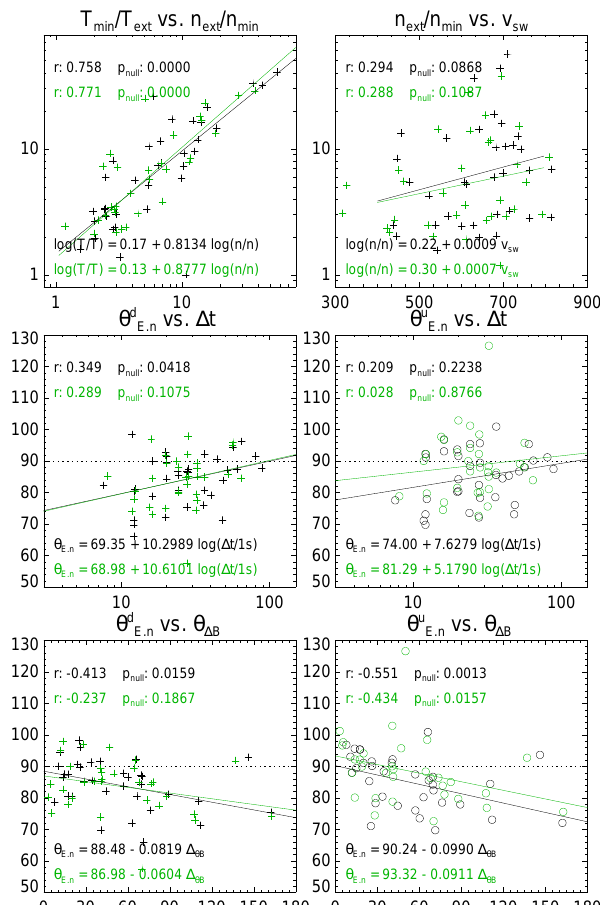
Fig. 12. Fig. 12. Correlations. T min / T ext vs. n ext / n min ; n ext / n min vs. v sw ; θ d vs. n ext / n min ; θ u vs. n ext / n min ; θ d E · n E · n θ d vs. θ 1B ; θ u vs. θ 1B E · n E · n